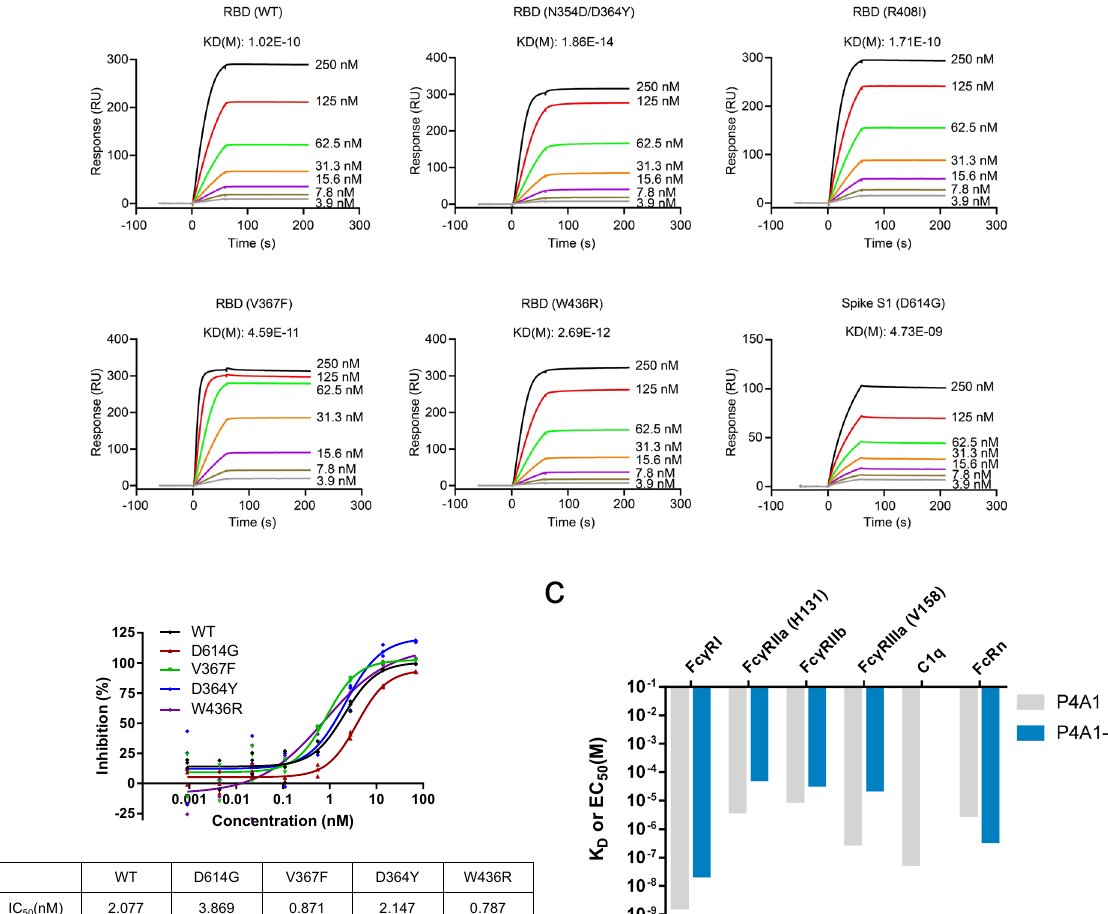
Fig. 3 The activities of IgG4 antibody P4A1 – 2A to different SARS-CoV-2 S protein mutants, FcRs, and C1q. a Binding of antibody P4A1 to SARS-CoV-2 S protein N354D/D364Y, R408I, W436R, V367F, or D614G mutants determined by surface plasmon resonance (SPR). b Pseudovirus neutralization assay in hACE2-overexpressing HEK293 cells. Experiment performed in triplicates with symbols represent each of the triplicates. c The binding af fi nity of P4A1 and P4A1 – 2A for different human FcRs and complement